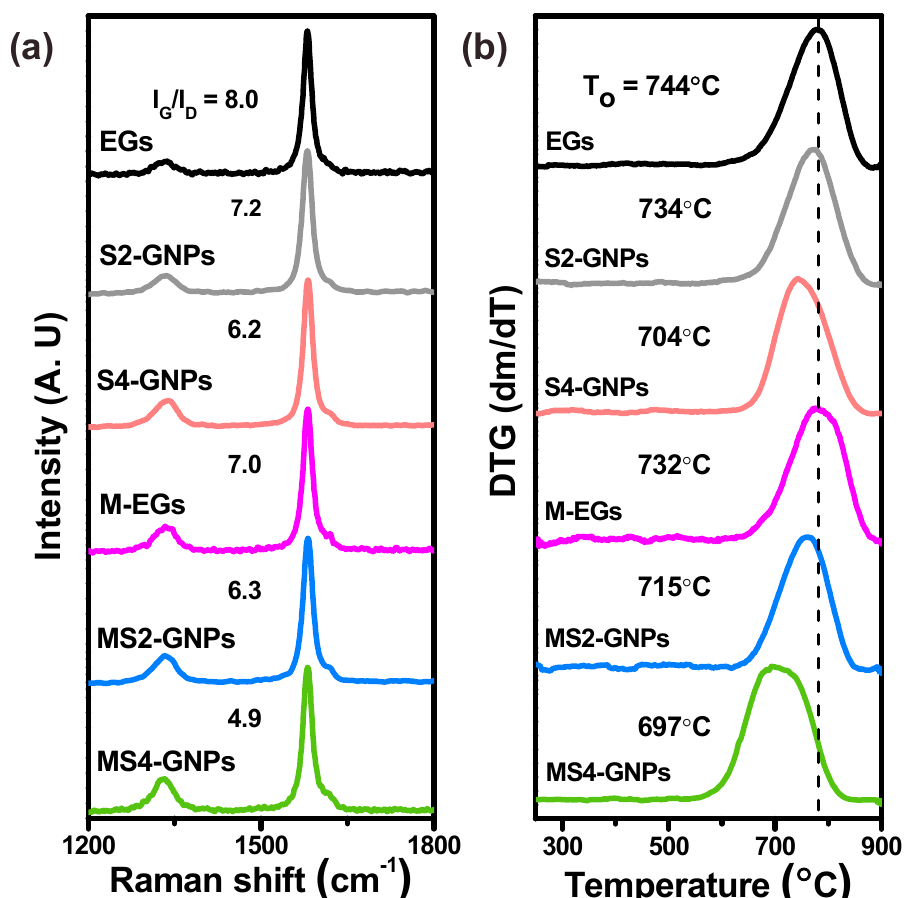
Figure 3. ( a ) Raman spectra and ( b ) derivative thermogravimetric (DTG) curves of EGs and GNPs. The G − to − D peak intensity ratios (I G /I D ) of the Raman spectra and the oxidation temperatures (T ox ) from the peaks of DTG curves are shown.